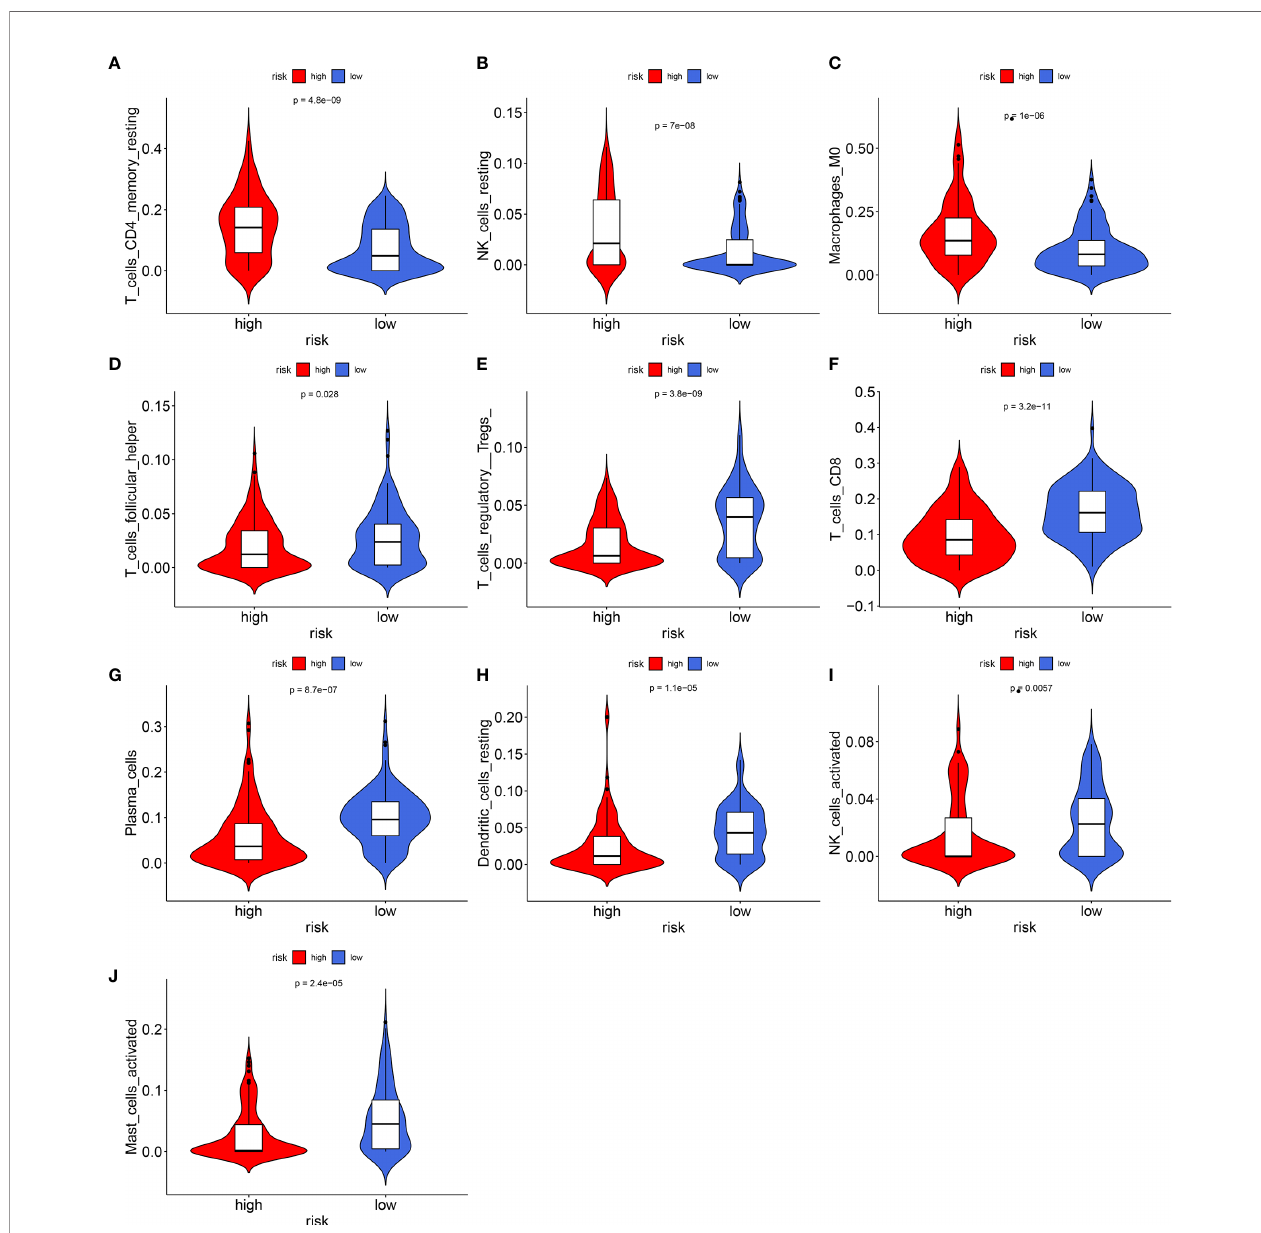
FIGURE 5 | Violin plots showing the relationship between the signature and in fi ltration levels of 22 kinds of immune cells. (A) T cells CD4 memory resting; (B) NK cells; (C) macrophage M0; (D) T cells follicular helper; (E) T cells regulatory; (F) T cells; (G) plasma cells; (H) dendritic cells; (I) NK cells; (J) mast cells activated. Red indicates high recurrence risk group and blue indicates low recurrence risk